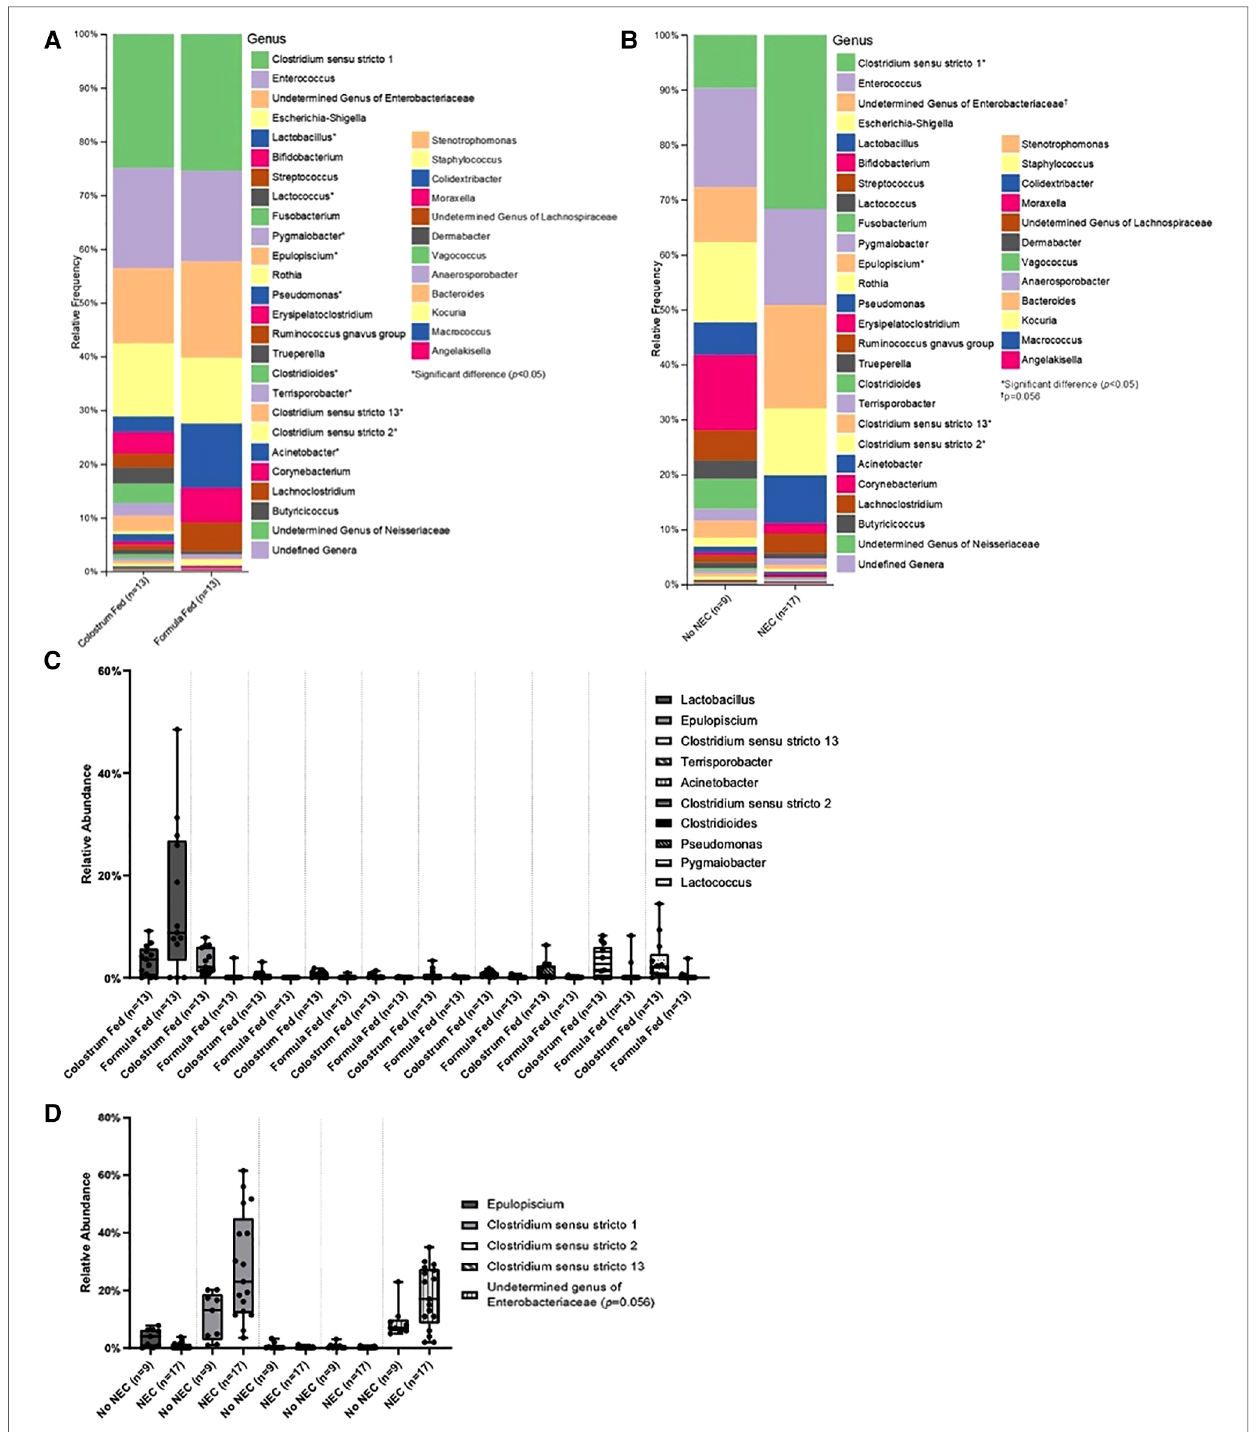
FIGURE 9 Genus level taxonomic abundance. Genus level taxa distribution within ( A ) feeding regimen and ( B ) occurrence of NEC. Bars represent mean relative percentage of each corresponding bacterial genera. Distribution of signi fi cantly different genera within ( C ) feeding regimen and ( D ) occurrence of NEC as box and whisker plots that denote minimum, maximum, and interquartile range values. For all relative abundance data, pairwise comparisons between groups were made using the Kruskal-Wallis test ( p